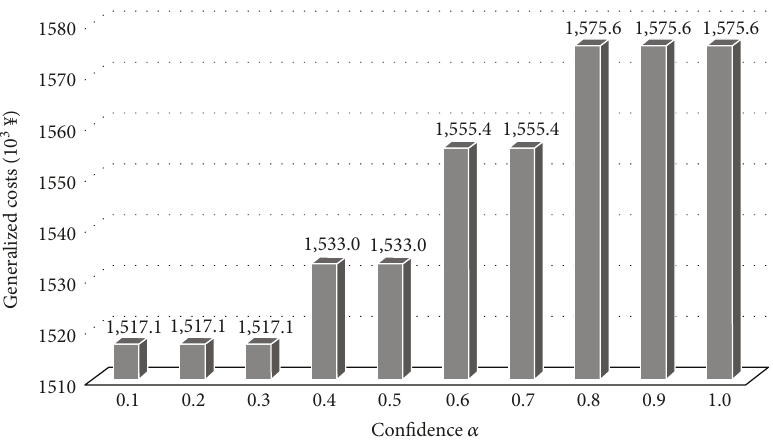
Figure 9: Sensitivity of the multimodal routing with respect to the con fi